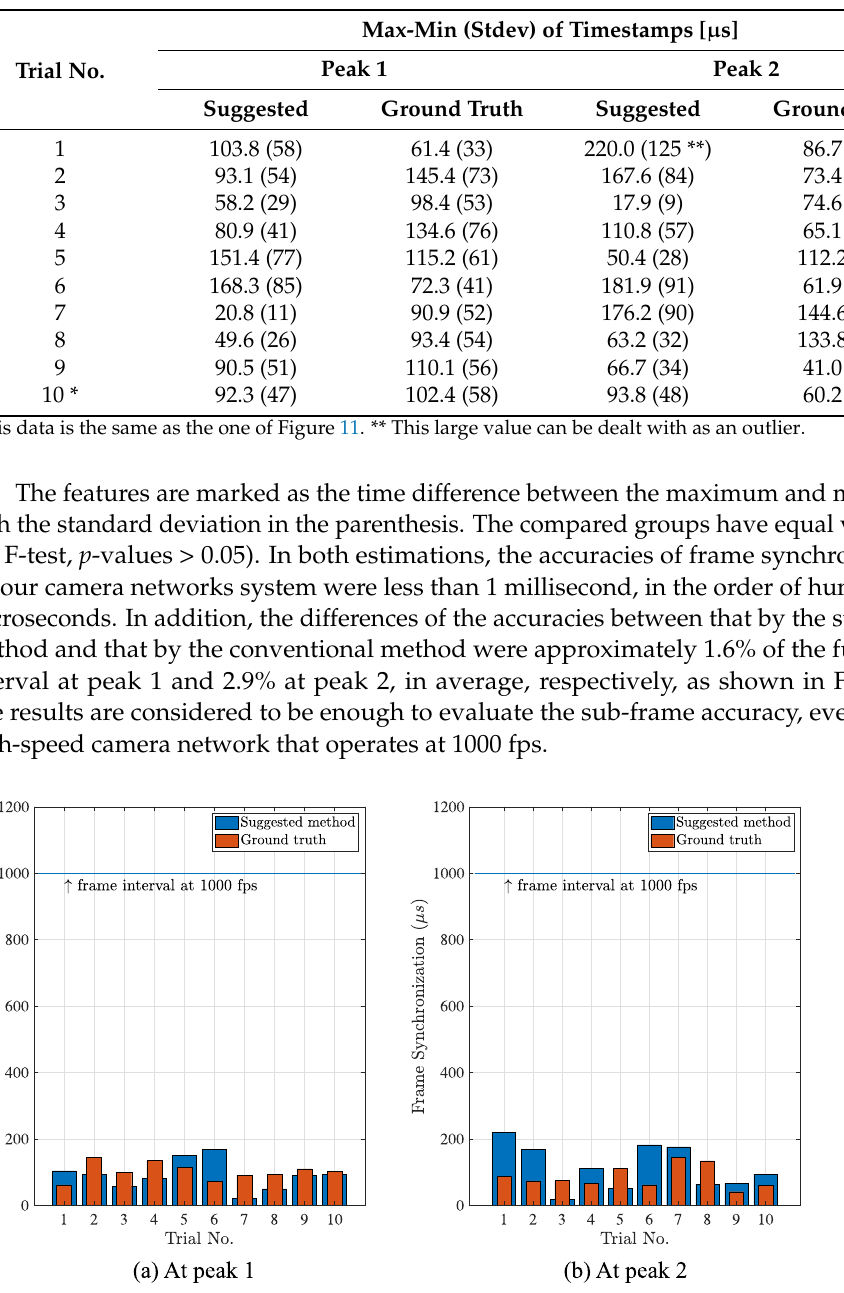
Table 1. The frame synchronization estimated at two peak points.